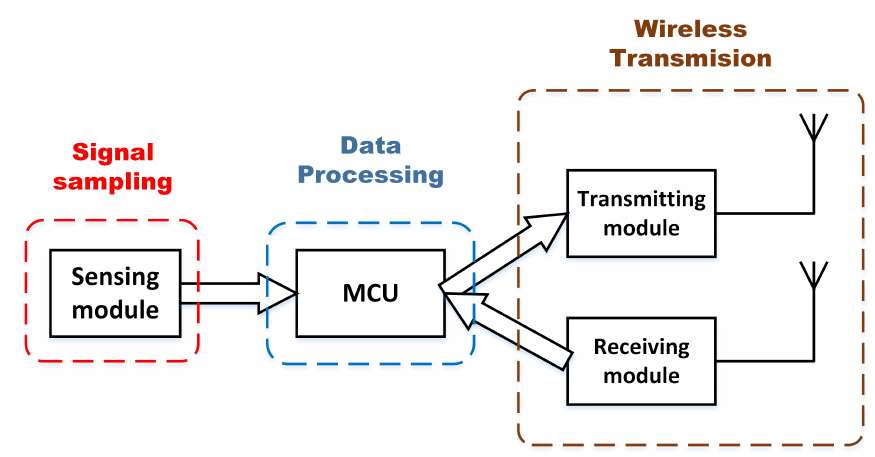
Figure 16. Architecture of the system.